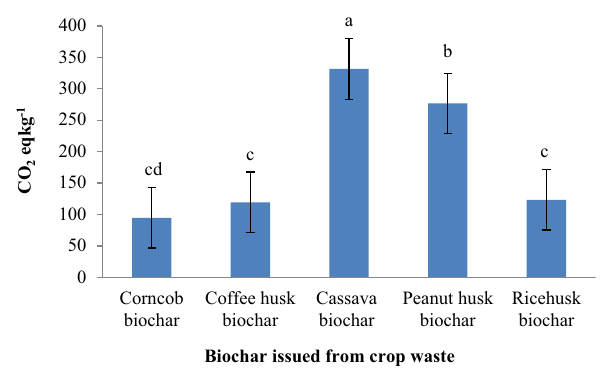
Fig. 6 Quantity of CO 2 captured in the biochar issued from crop wastes. Bars display the standard error of the